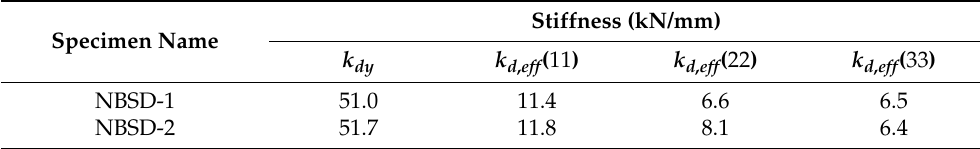
Table 3. Effective stiffnesses of the NBSD-based seismic control system.